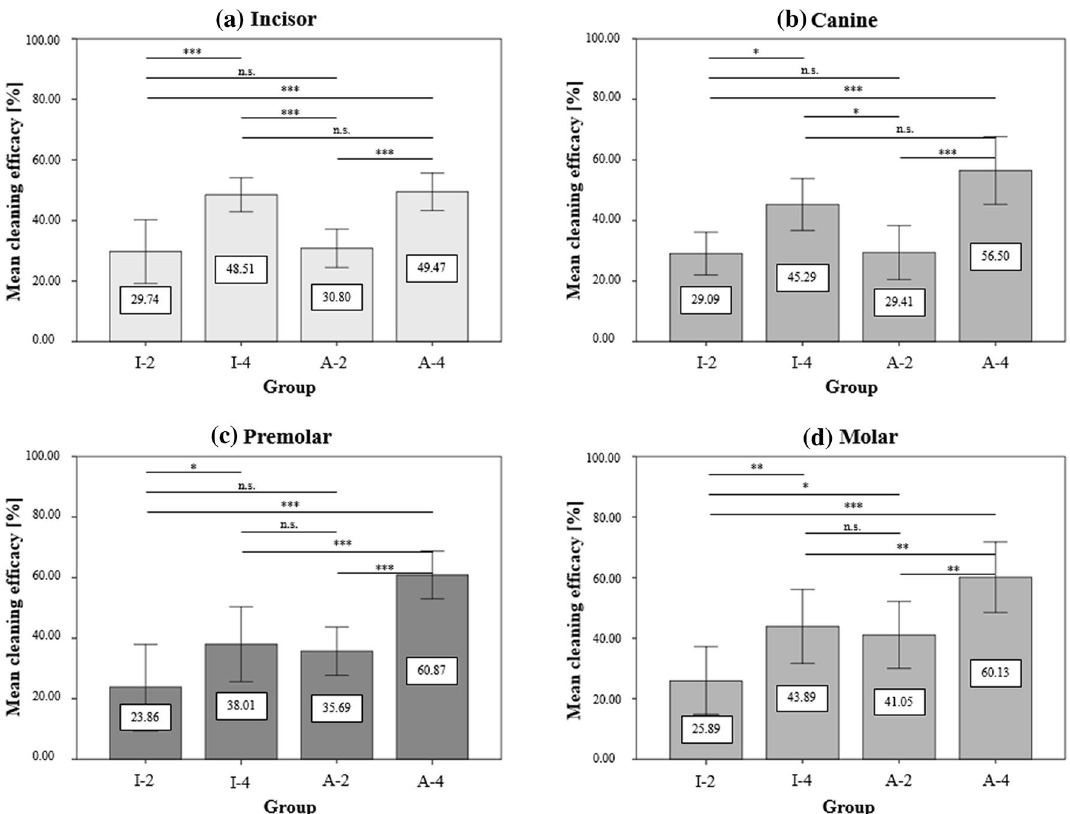
Figure 6. The means and standard deviation of the cleaning efficacy of the incisors ( a ), canines ( b ), premolars ( c ), and molars ( d ). Horizontal lines with “***” describe significant differences with p < 0.001, “**” with p < 0.01, and “*” with p < 0.05 between the I-Prox brush applied for two (I-2) and four seconds (I-4) as well as the AirFloss with two (A-2) and four sprays (A-4). “n.s.” indicates no significant differences.